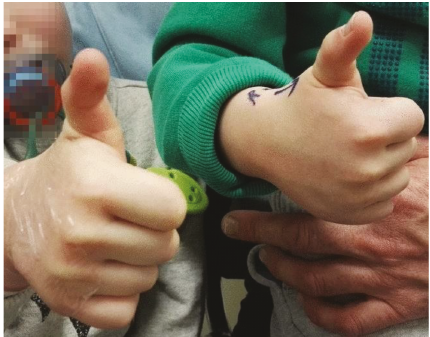
Figure 1: Ipsilateral trigger thumbs.